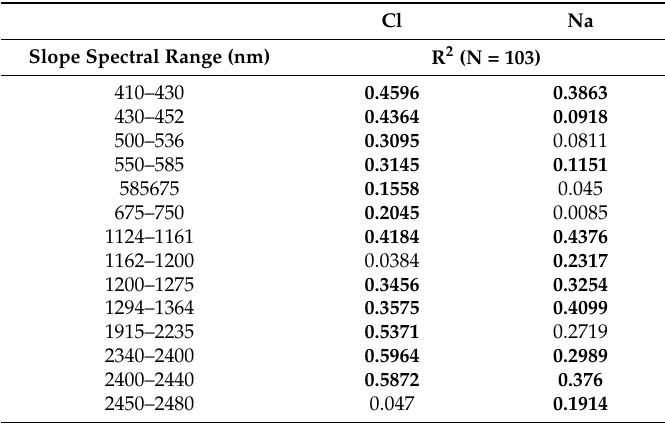
Table 2. Coefficient of determination between slopes in selected spectral regions and Cl and Na contents of vegetation. The bold numbers are the selected range for Cl and/or for Na. Cl